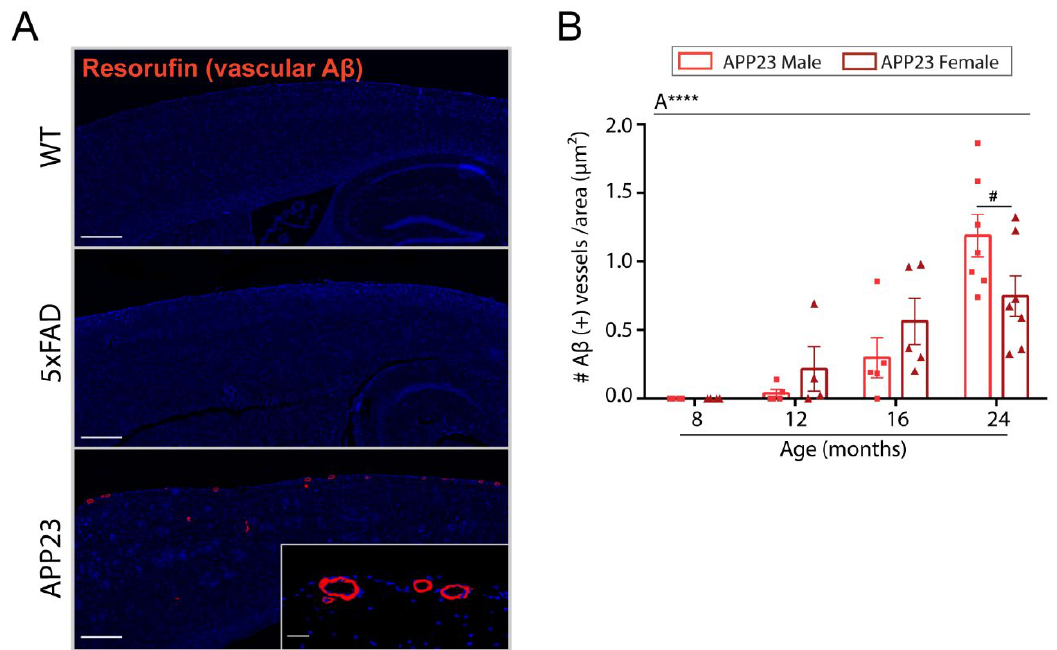
Figure 3. Vascular Aβ deposition in 5xFAD and APP23 mice. ( A ) Representative images of resorufin staining in 16-month-old WT, 5xFAD, and APP23 female mice. Scale bar indicates 200 μm and 20 μm , respectively. ( B ) Quantification of the number of Aβ -positive vessels identified by resorufin staining in APP23 mice. Data are expressed as the number of Aβ -positive vessels per area (pixels 2 ). n = 4–7/group. The effect of sex (S) and age (A) was evaluated in each subgroup of data. Statistical differences were analyzed among groups as indicated and represented as: # p < 0.1, **** p < 0.0001.